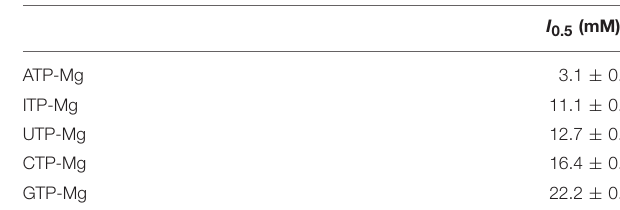
TABLE 4 | Inhibition of the pyrophosphorolysis activity with the different